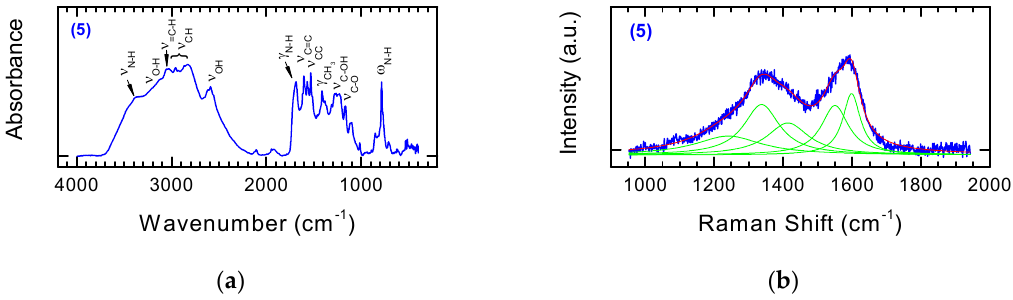
Figure 9. FT-IR ( a ) and Raman spectra ( b ) of NDPs modified with an isokinetic mixture contained 1,5-diaminonaphthalene and p-aminobenzoic acid.